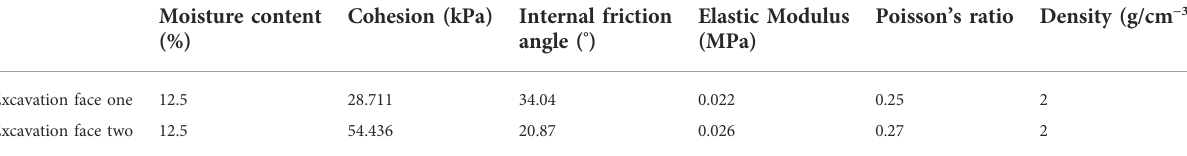
TABLE 1 Mechanical properties of sandy soil.